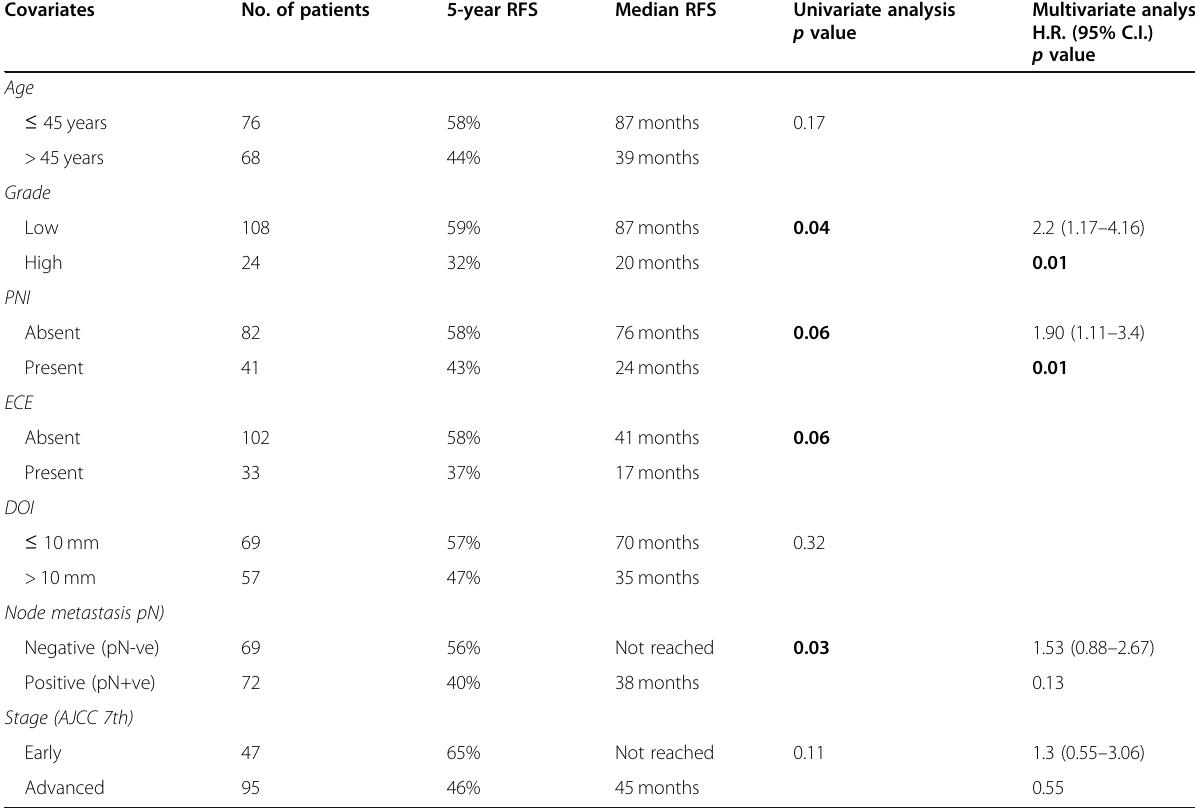
Table 3 Impact of prognostic factors on recurrence-free survival (RFS) ( N = 144)